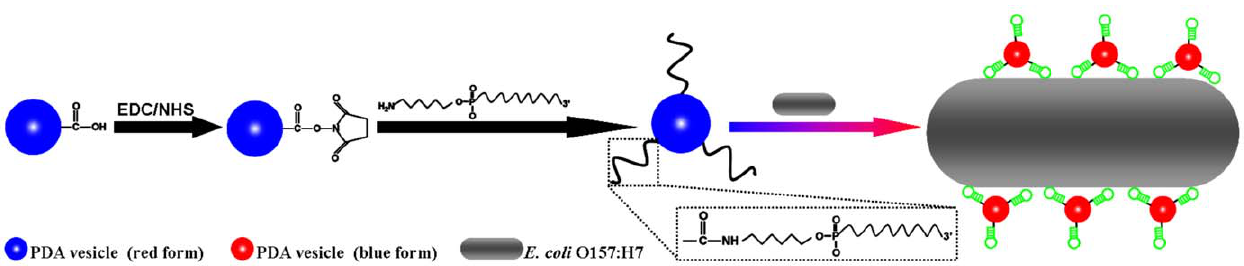
Figure 1. Principle of E.coli O157:H7 detection using aptasensor.